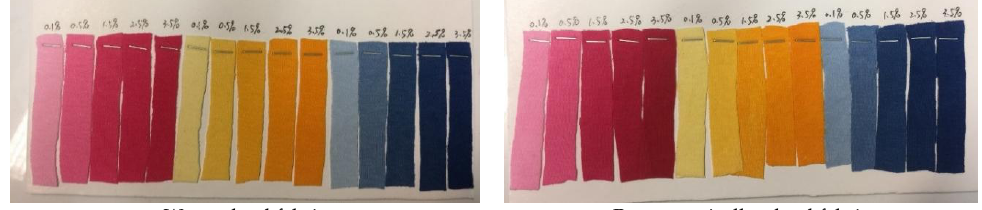
Figure 7. Dyeing results.